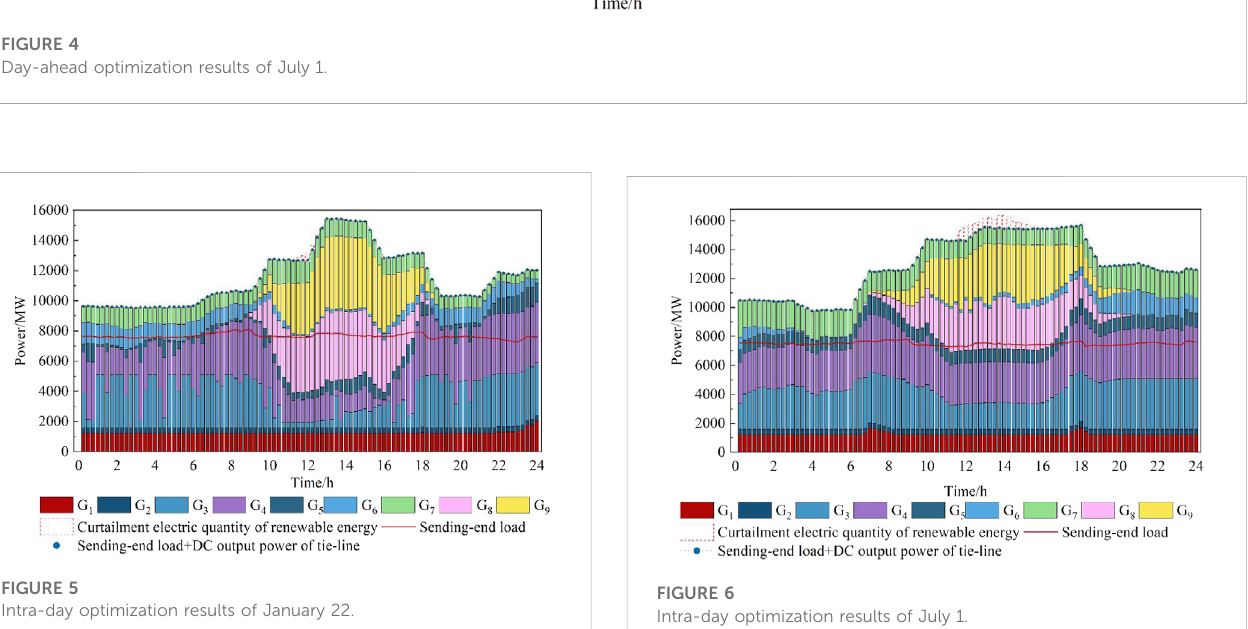
FIGURE 6 Intra-day optimization results of July